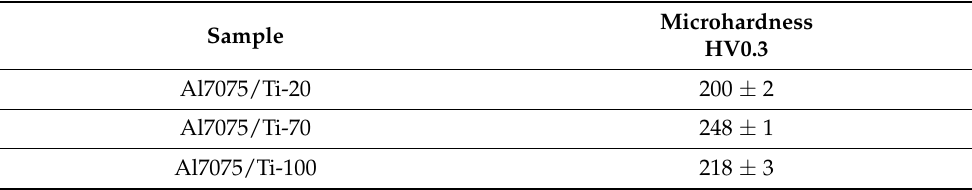
Table 2. Microhardness of titanium coatings onto Al7075